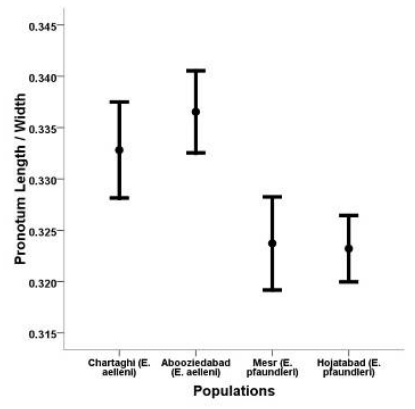
F IGURE 8. - The 95% confidence intervals of pronotum length/width ratio of four Eriodontes spp. populations.